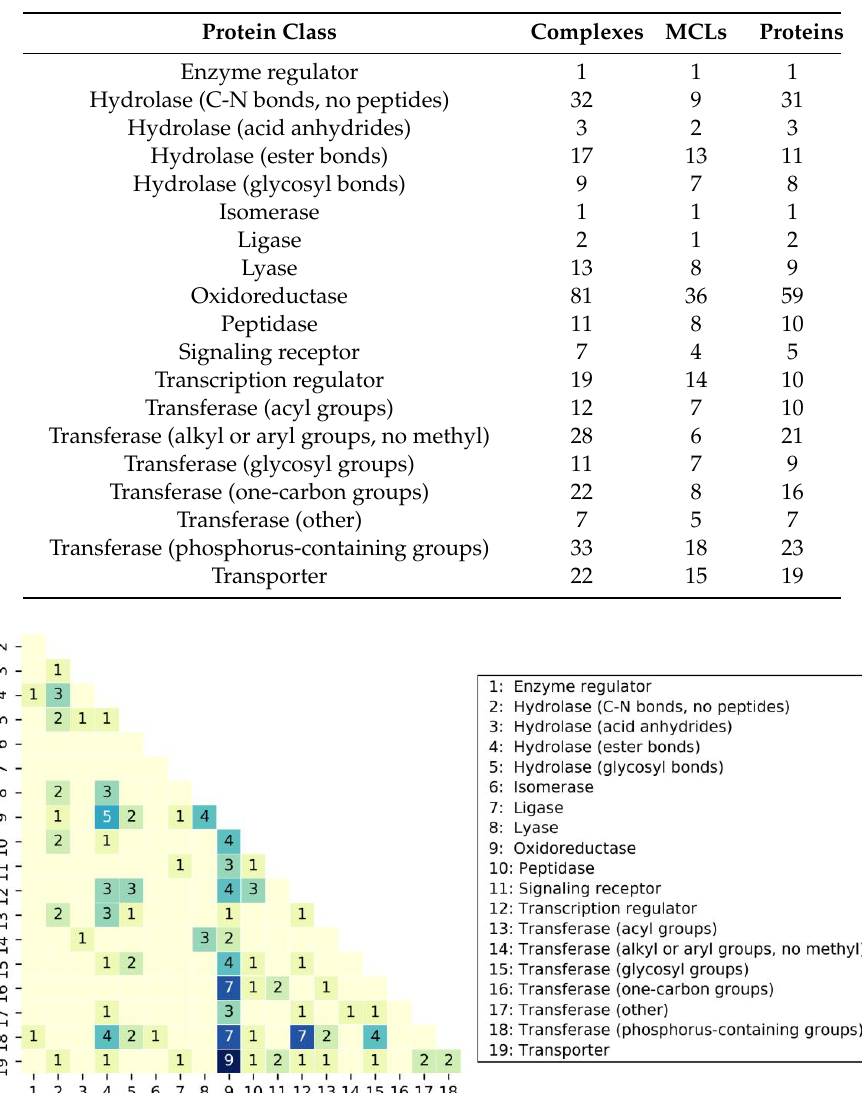
Table 1. MCL complexes. X-ray structures of complexes with MCLs are organized by protein class. For each class, the number of complexes, unique MCLs, and unique target proteins is reported.